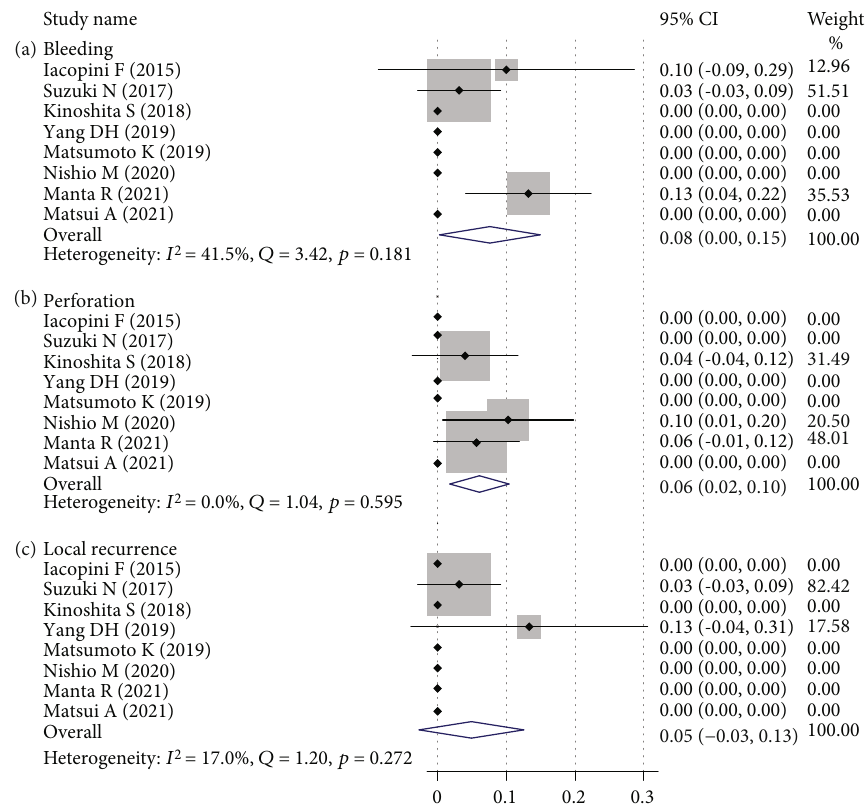
Figure 3: Prevalence of complications and pooled estimates of endoscopic submucosal